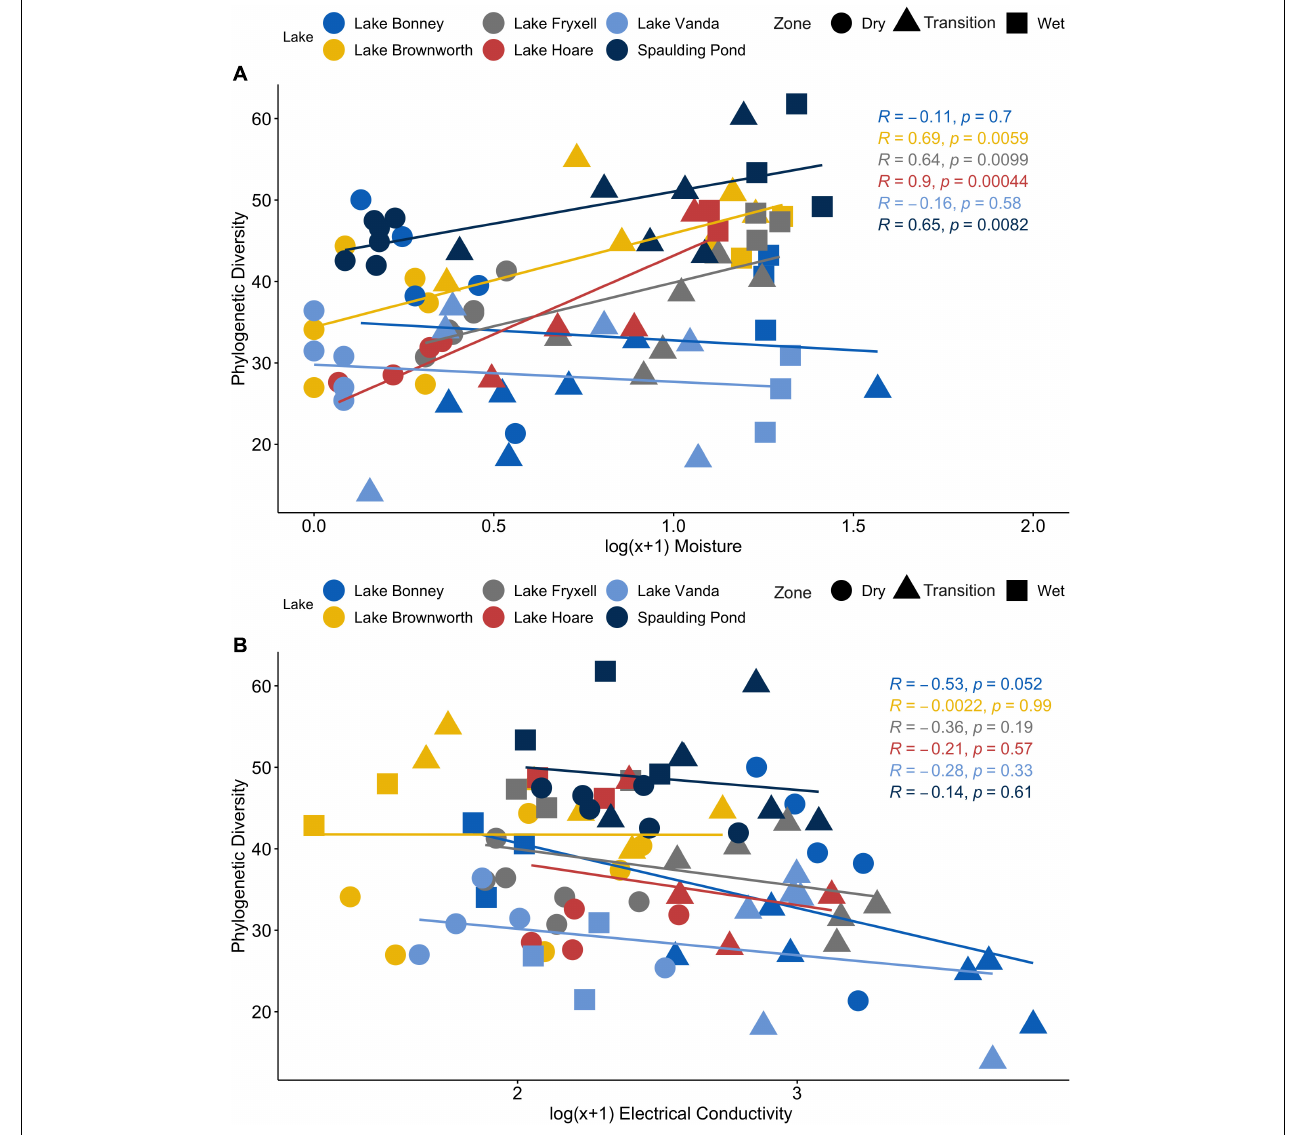
FIGURE 3 | (A) Relationship between Phylogenetic Diversity (PD) and log transformed moisture content measurements across the SFT transects from Lake Brownworth, Lake Bonney, Lake Fryxell, Lake Hoare, Spaulding Pond, and Lake Vanda. (B) Relationship between Phylogenetic Diversity (PD) and log transformed electrical conductivity measurements across the SFT transects from Lake Brownworth, Lake Bonney, Lake Fryxell, Lake Hoare, Spaulding Pond, and Lake